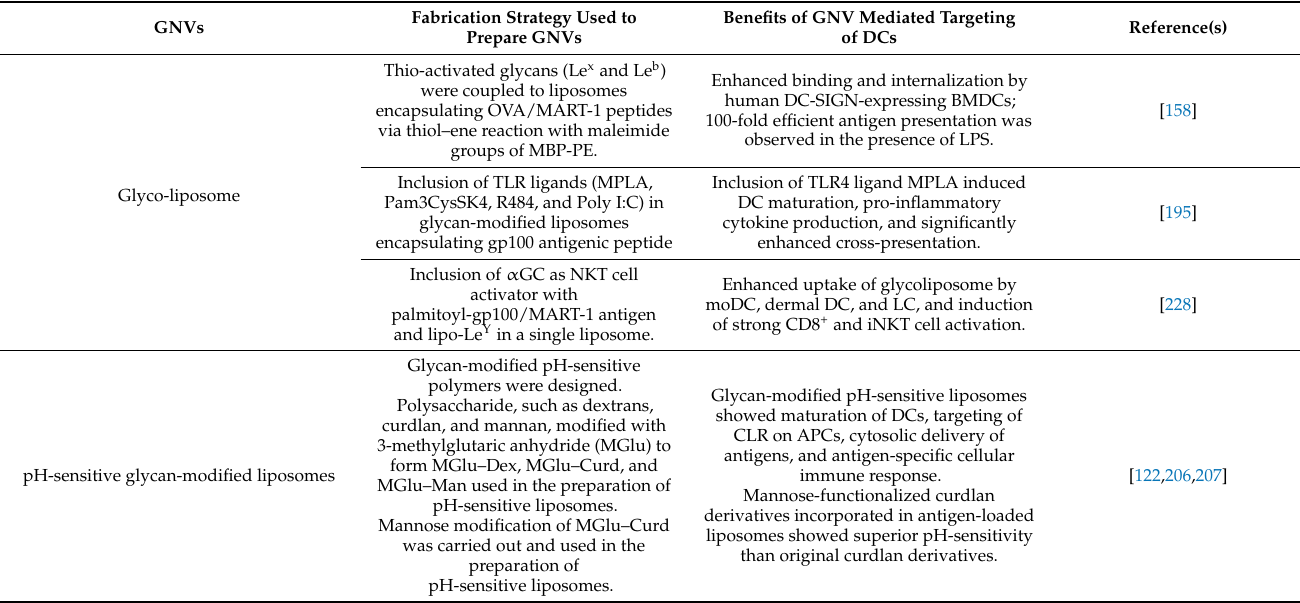
Table 4. GNV fabrication strategy and their benefits in anti-tumor